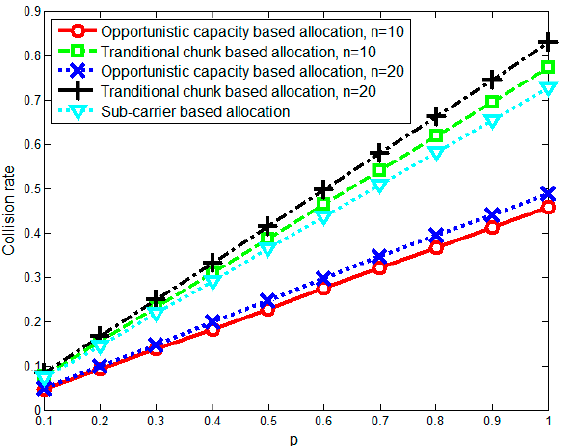
Figure 6. Average spectrum collision rate with different chunk capacity change rates p .